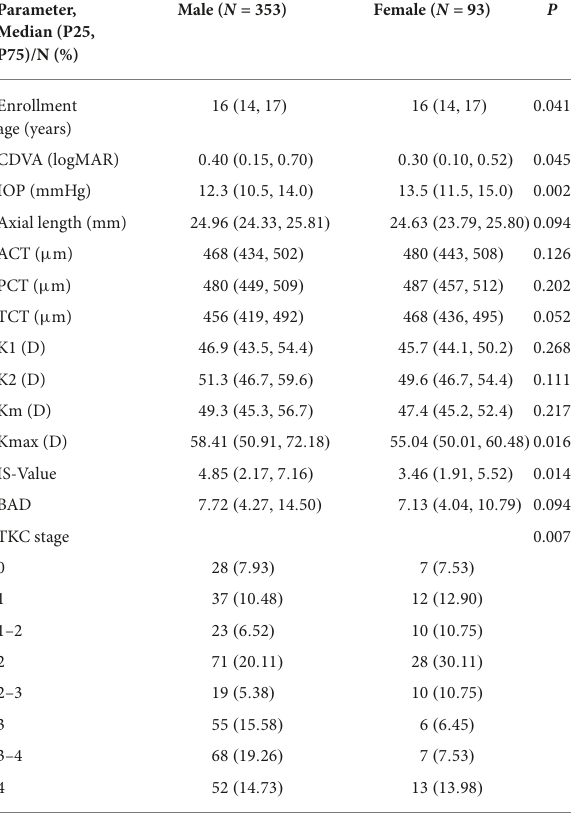
TABLE 2 Distribution of keratoconus by gender